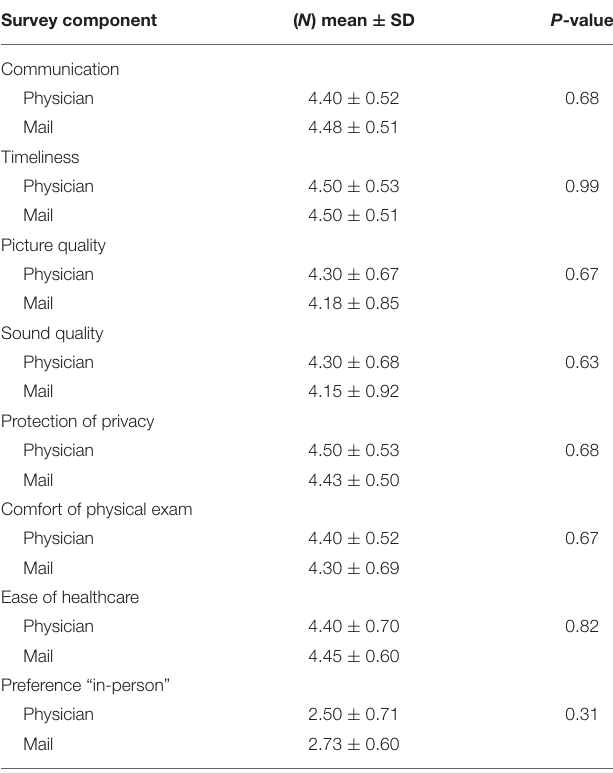
TABLE 4 | Average response ratings for survey administered by physician vs. mail. Survey